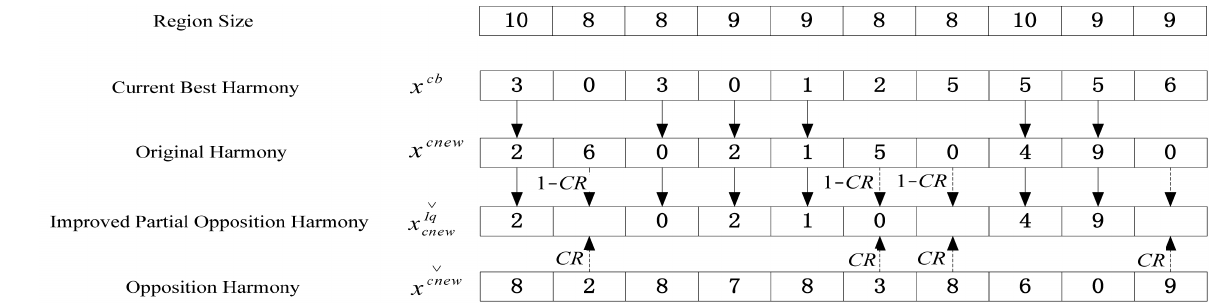
Fig. 2 The solution of improved partial opposition-based